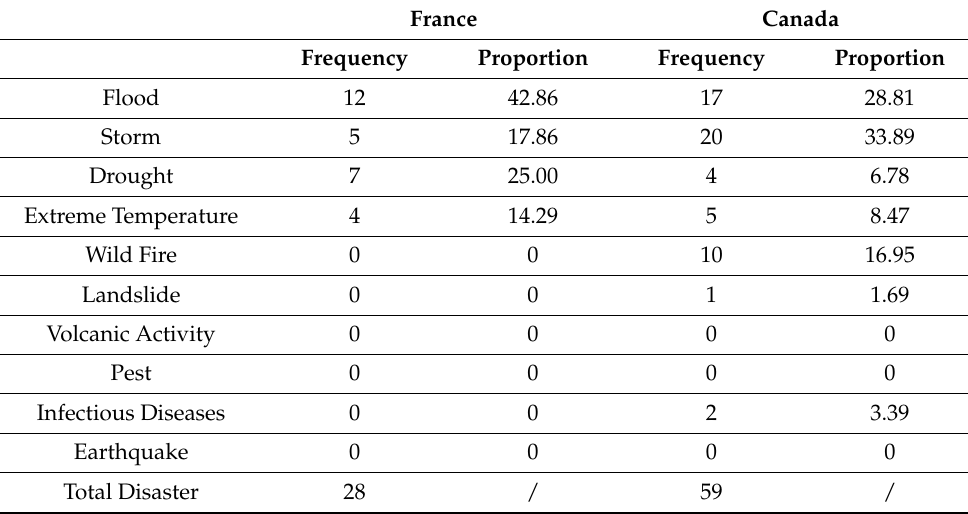
Table 1. Overview of natural disasters in main producing areas of major barley-exporting countries